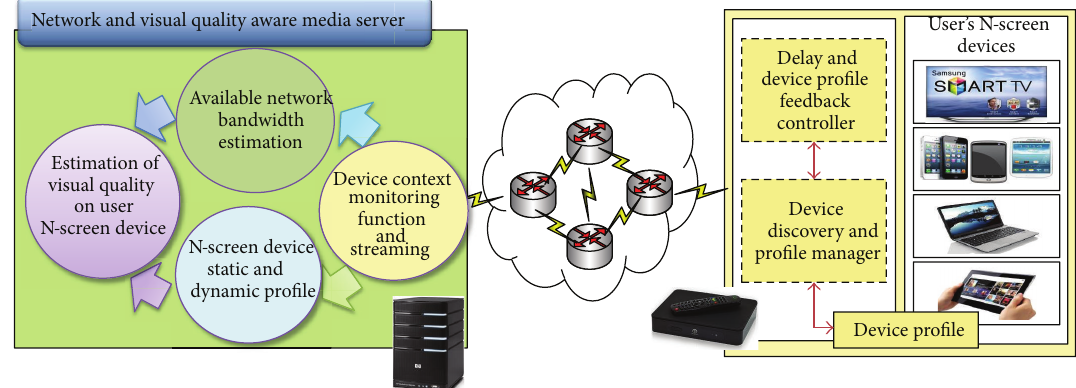
Figure 3: Architecture of network and visual quality estimation on user’s N-Screen device.